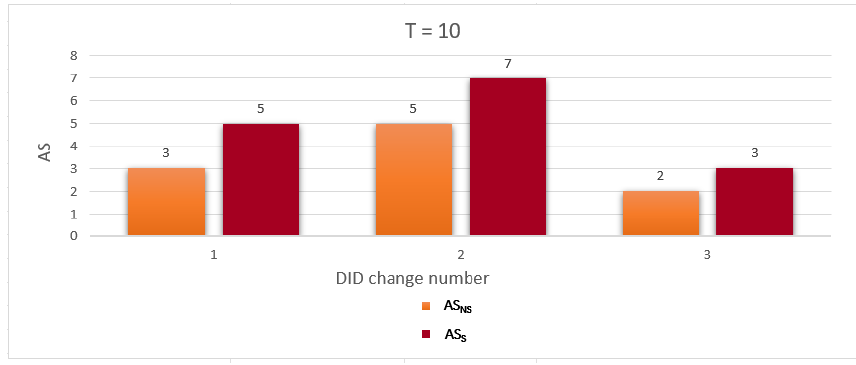
Figure 8. Anonymity of the source node (AS) for each DID change with 10 nodes.